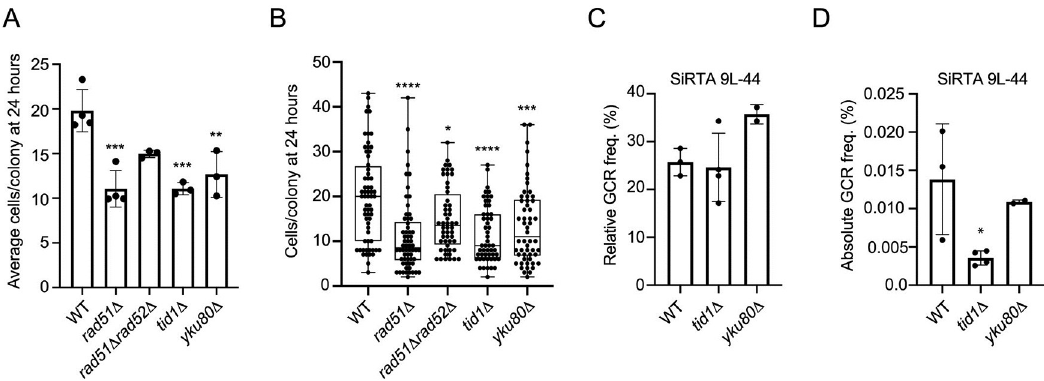
Fig 5. Adaptation-defective strains do not show consistently reduced GCR formation at SiRTA. Individual unbudded cells from the indicated strains were micro-manipulated on an agar plate containing galactose (to induce HO endonuclease expression). After 24 hours, the number of cells in each colony was determined. (A) The average number of cells per colony after 24 hours is plotted as an average and standard deviation of 3 or 4 independent experiments. Each experiment followed the growth of 11–18 micromanipulated cells. Values that are statistically different from WT by ANOVA with Tukey’s multiple comparisons test are indicated by asterisks. All other pairwise comparisons are not significant. (B) Box and whisker plots show the median and 25 and 75% range of colony size for all micromanipulated cells analyzed in experiments summarized in A. Values that are statistically different from WT by ANOVA with Tukey’s multiple comparisons test are indicated by asterisks. All other pairwise comparisons are not significant. (C) The relative GCR frequency in SiRTA 9L-44 is shown for the indicated strains. (D) The absolute GCR frequency in SiRTA 9L-44 is shown for the indicated strains from the same experiment shown in C. For C and D, averages and standard deviations are from at least two independent experiments. Strains statistically different from the corresponding WT control strain by ANOVA with Dunnett’s multiple comparisons test are indicated by asterisks ( � p < 0.05; �� p < 0.01; ��� p < 0.001; ���� p <